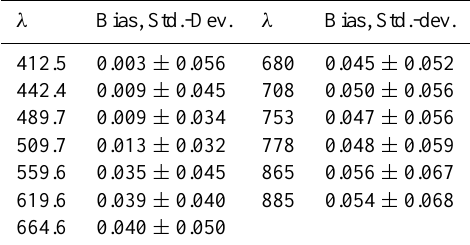
Fig. 4. Comparisons of ten collocated M ERIS /P MBAER measure- Fig. A4. Comparisons of ten collocated M ERIS /P MBAER measure- ments with A ERONET over Hamburg. Bars indicate the standard ments with A ERONET over Hamburg. Bars indicate the standard deviation. See Table 1 for exact values. deviation. See Table B1 for exact values.